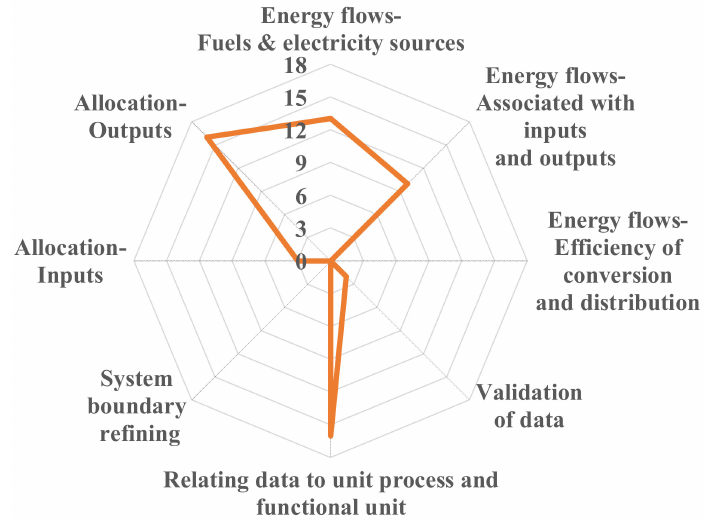
Figure 2. Life cycle inventory analysis of studied wave and tidal power systems. Note: the value of each item indicates the number of LCA studies that applied the specific method required in